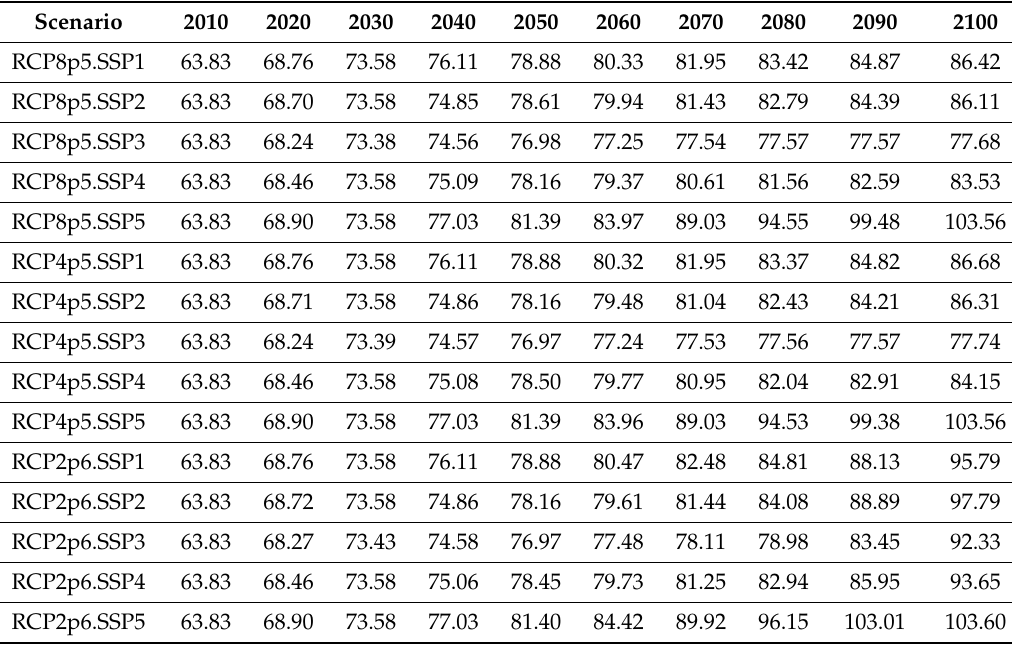
Table A2. Industrial roundwood harvest (millions of m 3 / year, under bark). Scenario